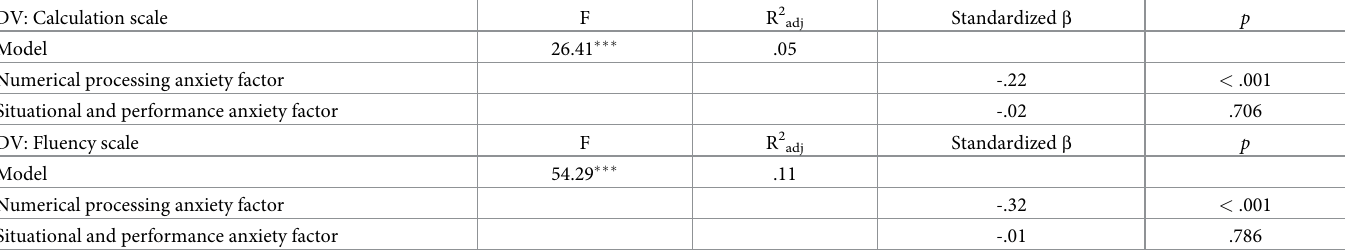
Table 7. Regressions analyses predicting WJ-III scale scores with numerical processing anxiety and situational and performance anxiety factors as independent